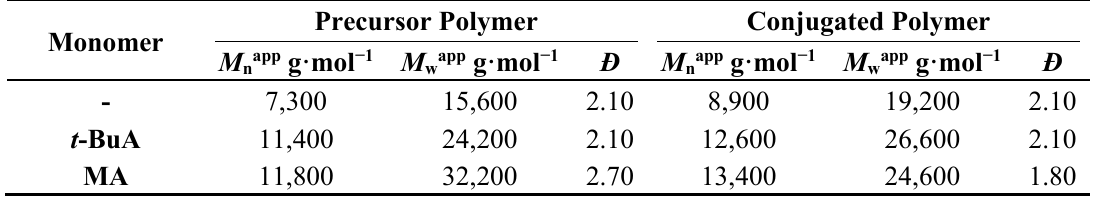
Table 5 . Apparent average molecular weights of block copolymers obtained from SET-LRP of CPM-PPV employing 100 equiv. of monomer and a reaction temperature of 25